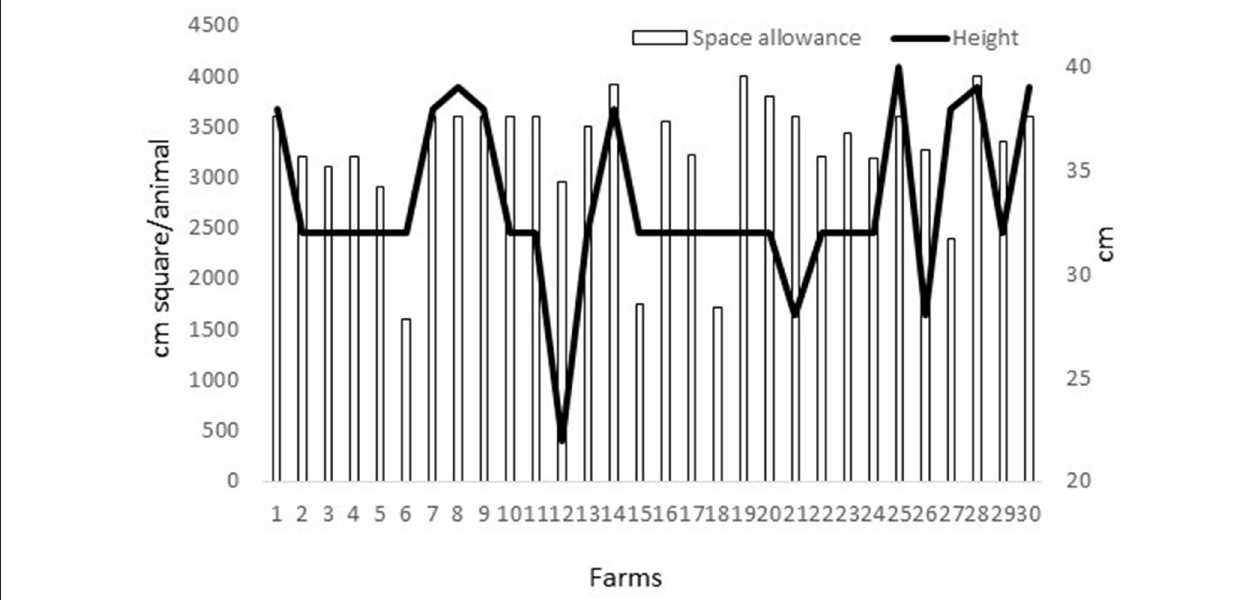
FIGURE 1 | Space allowance (cm 2 /doe or buck; with bars) and height (cm; black line) found in the 30 Spanish farms of bucks, does, and kit rabbits assessed during 2019.